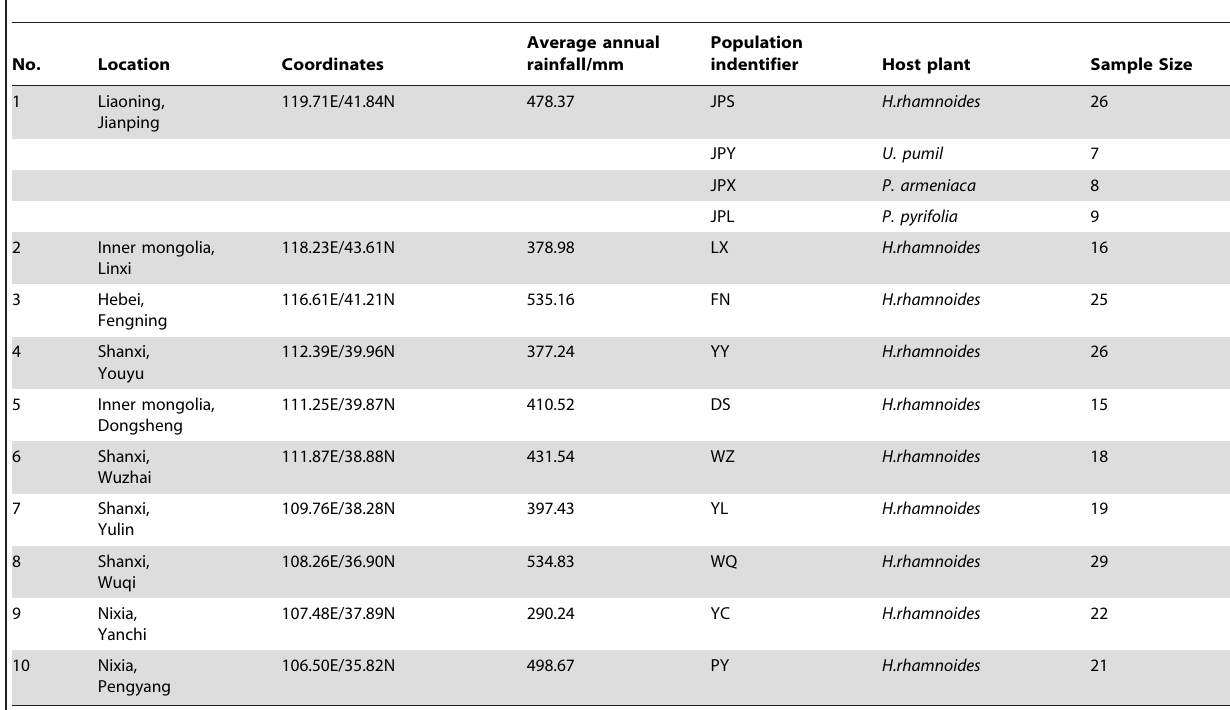
Table 1. Geographical location, average annual rainfall, and hosts for populations of H. hippophaecolus .